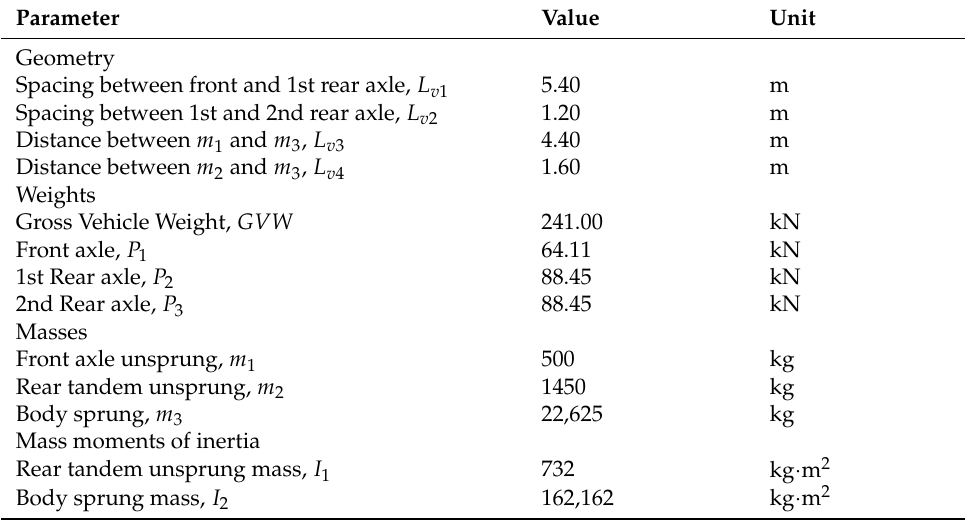
Table 2. Parameters of the vehicle